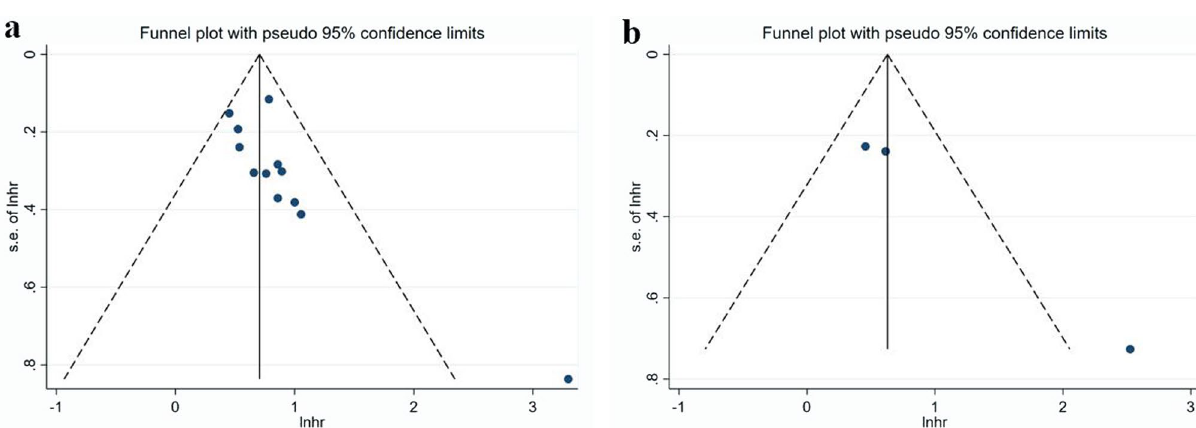
Figure 4. Funnel plots for the evaluation of publication bias. ( a ) For OS; ( b ) for RFS by multivariate analytic results.